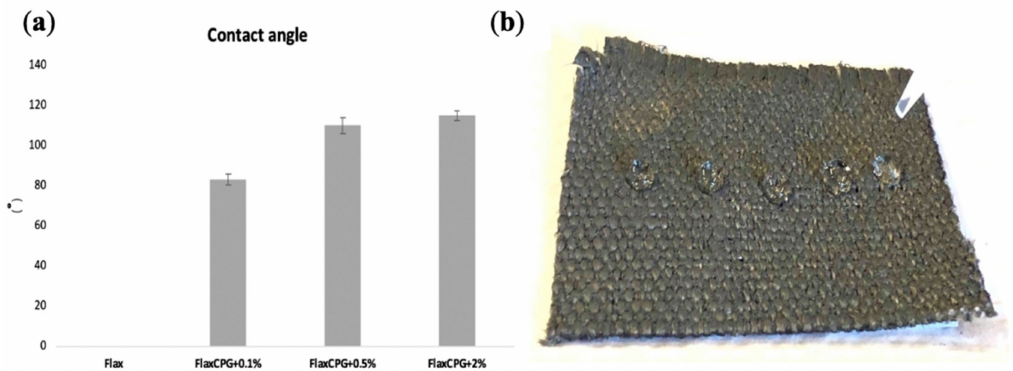
Figure 12. ( a ) average WCA obtained for treated flax, FlaxCPG + 0.1%, FlaxCPG + 0.5%, FlaxCPG + 2% and ( b ) WCA test of sample with 2%